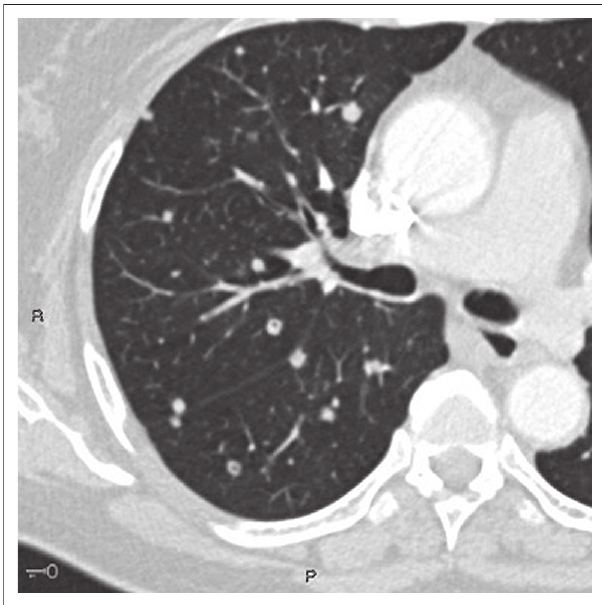
FIGURE 1: Computed tomography axial image through the right lung base demonstrates early central cavitation of the pulmonary